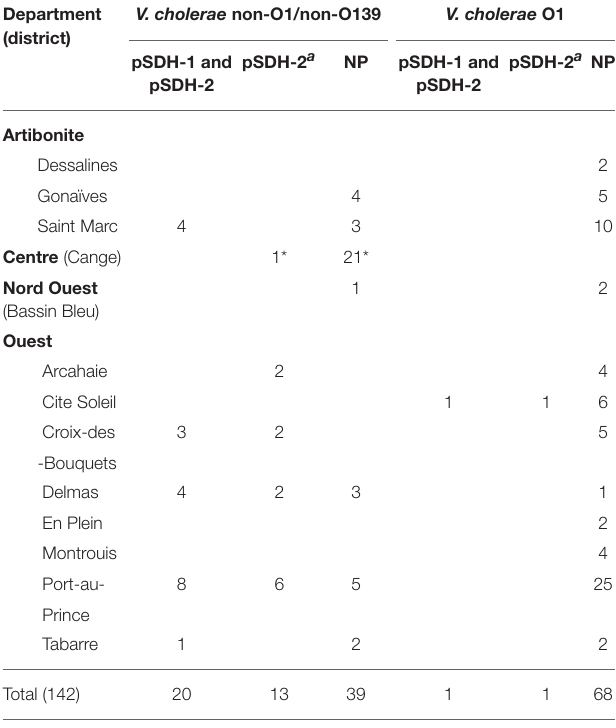
TABLE 2 | Distribution of pSDH-1 and pSDH-2 among clinical V. cholerae non-O1/non-O139 and O1 isolated in different Haitian